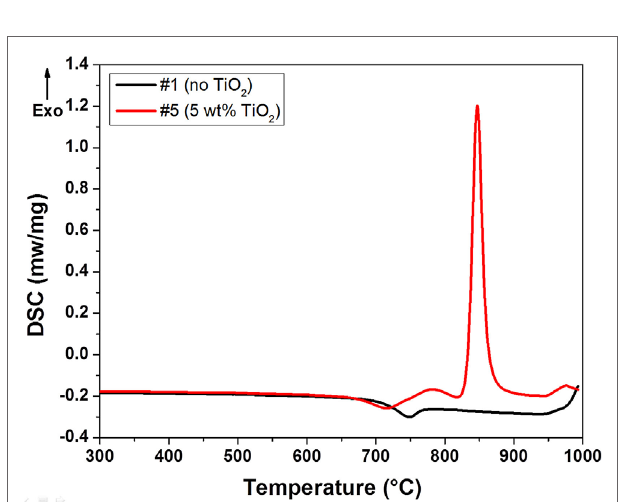
FigUre 1 | X-ray diffraction patterns of annealed glasses (compositions #1, 4–7) .